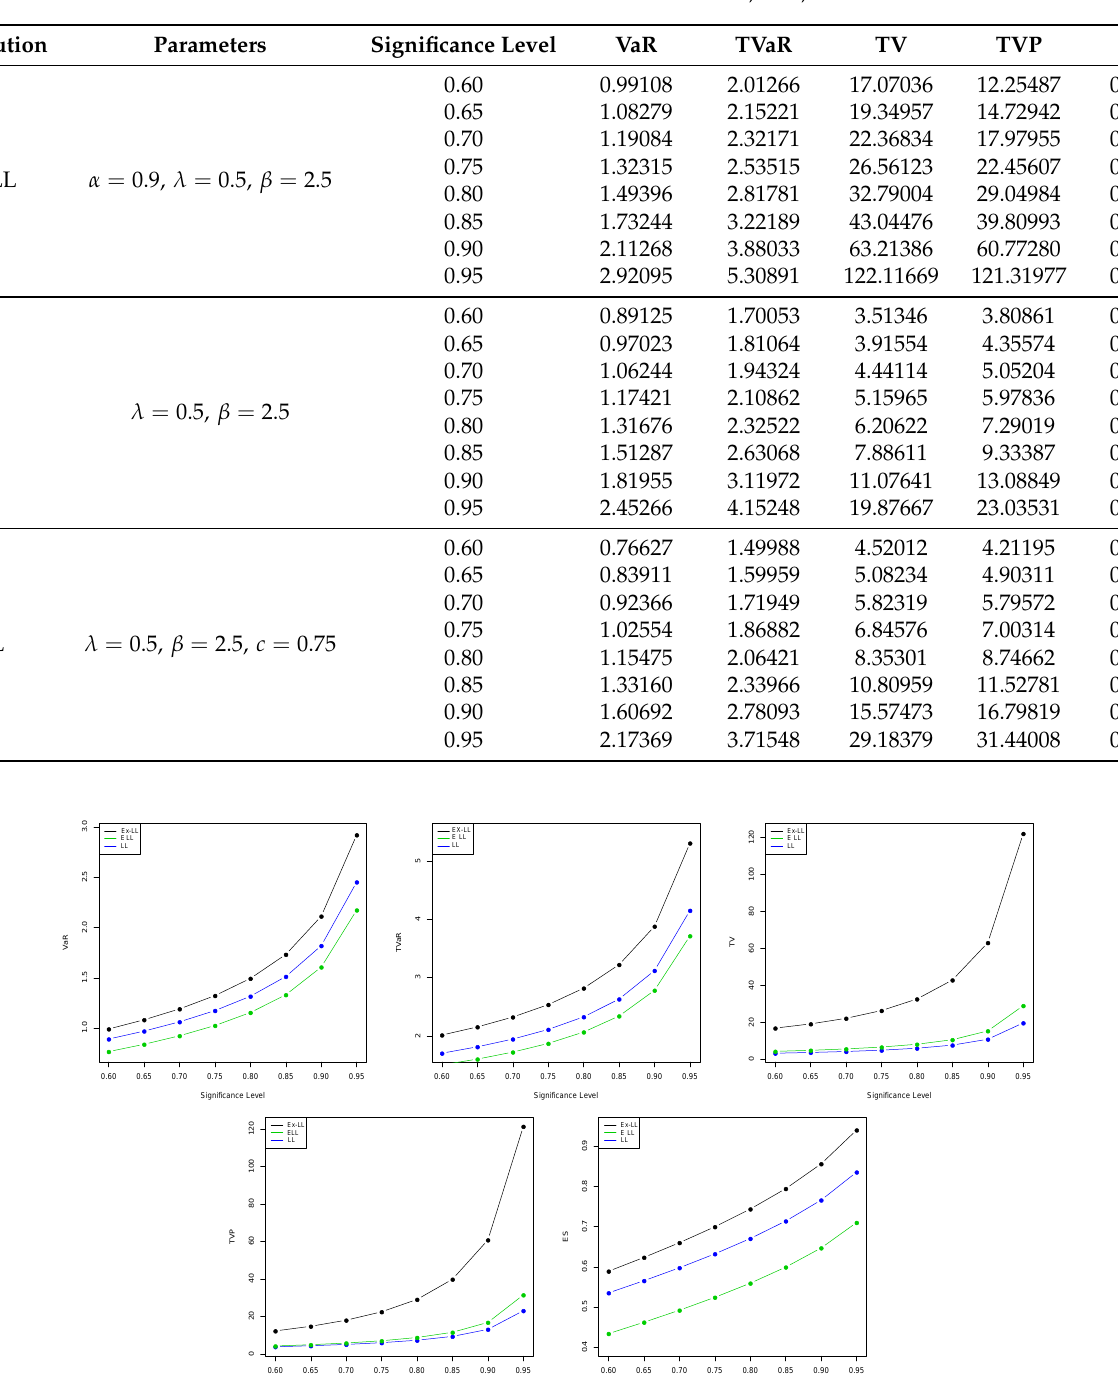
Table 10. Simulation results of the five risk measures for the Ex-LL, ELL, and LL distributions. Distribution Parameters Significance Level VaR TVaR TV TVP ES 0.60